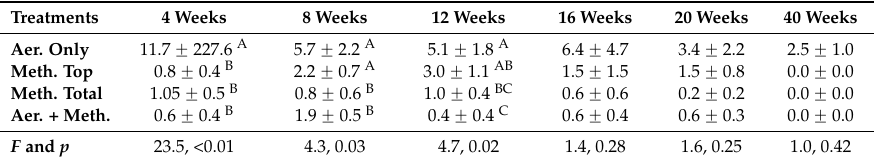
Table 2. Mean numbers ( ˘ SE) of adult T. castaneum collected in grain trier samples at different times after bins were loaded with wheat that was either treated with aeration only, the top 50 cm-treated with methoprene, methoprene treatment to all the wheat in a bin, or aeration plus complete treatment with methoprene on all grain in the bin. Means within columns with the same upper case letter, for which there was a significant ( p < 0.05) F-statistic, are not significantly different (LSD test, p < 0.05, SAS Institute, degrees of freedom for analysis within date for treatment were 3,